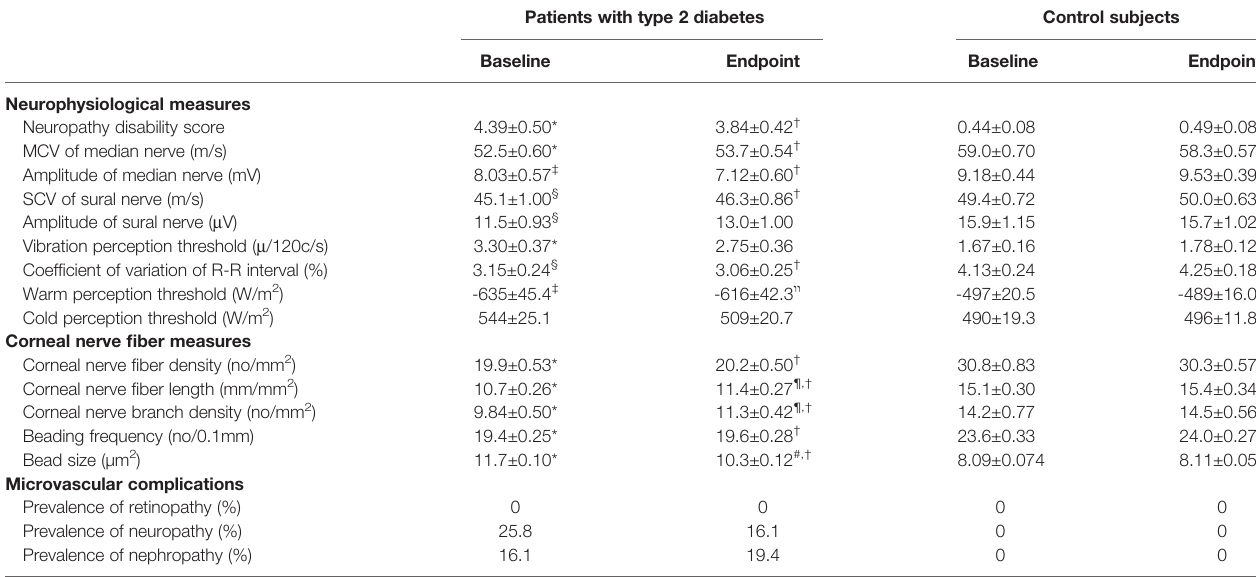
TABLE 2 | Neurophysiological measures, corneal nerve fi ber measures and microvascular complications at baseline and endpoint in patients with type 2 diabetes and control